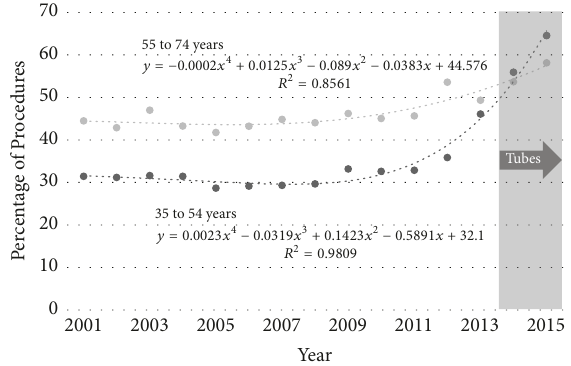
Figure 5: Age-stratified incidence rates for different routes of hysterectomy ( X vaginal, ◼ abdominal, and 󳵳 laparoscopic) in Australia (procedures per 10000 women) for women aged 55–74 years.